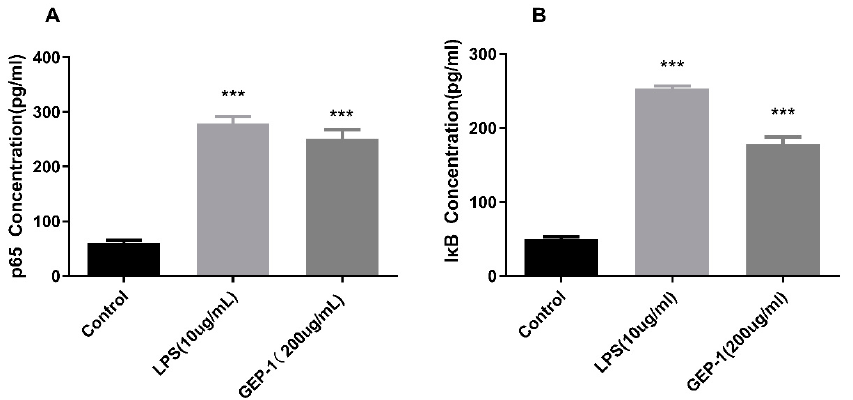
Figure 7. Effects of GEP-1 on p65 (NF- κ B) ( A ) and I κ B ( B ) protein expression in RAW264.7 cells. *** denotes the differences between the control group and other groups, *** p < 0.001.